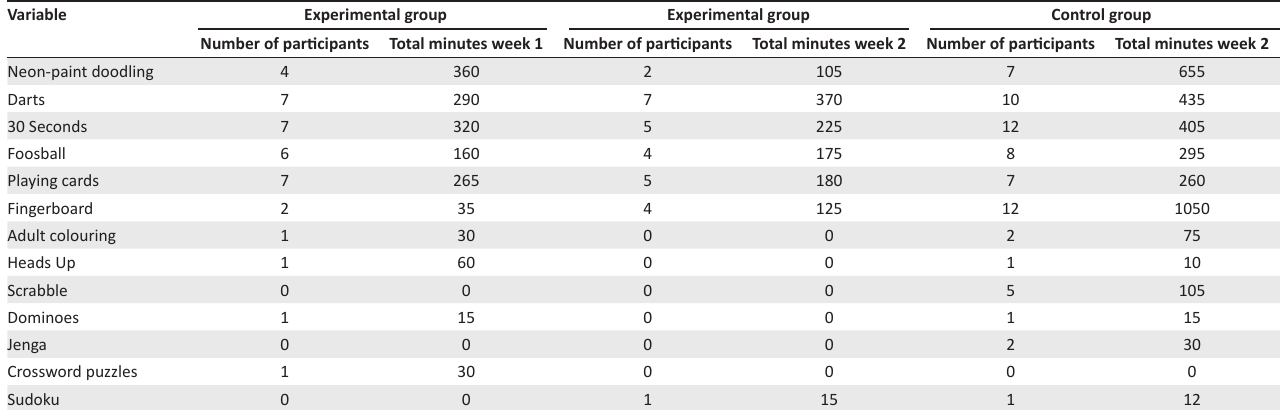
TABLE 6: Collective minutes played per team, per week. Variable Experimental group Experimental group Control